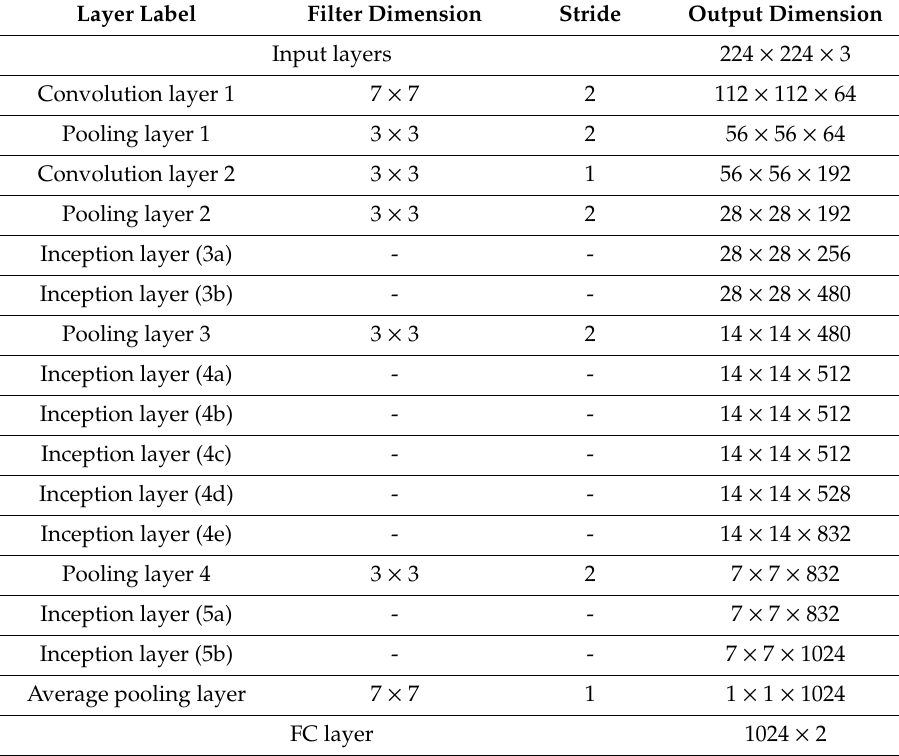
Figure 3. The architecture of the GoogleNet deep convolution neural network (DCNN). Table 2. Di ff erent layers dimension of a GoogleNet